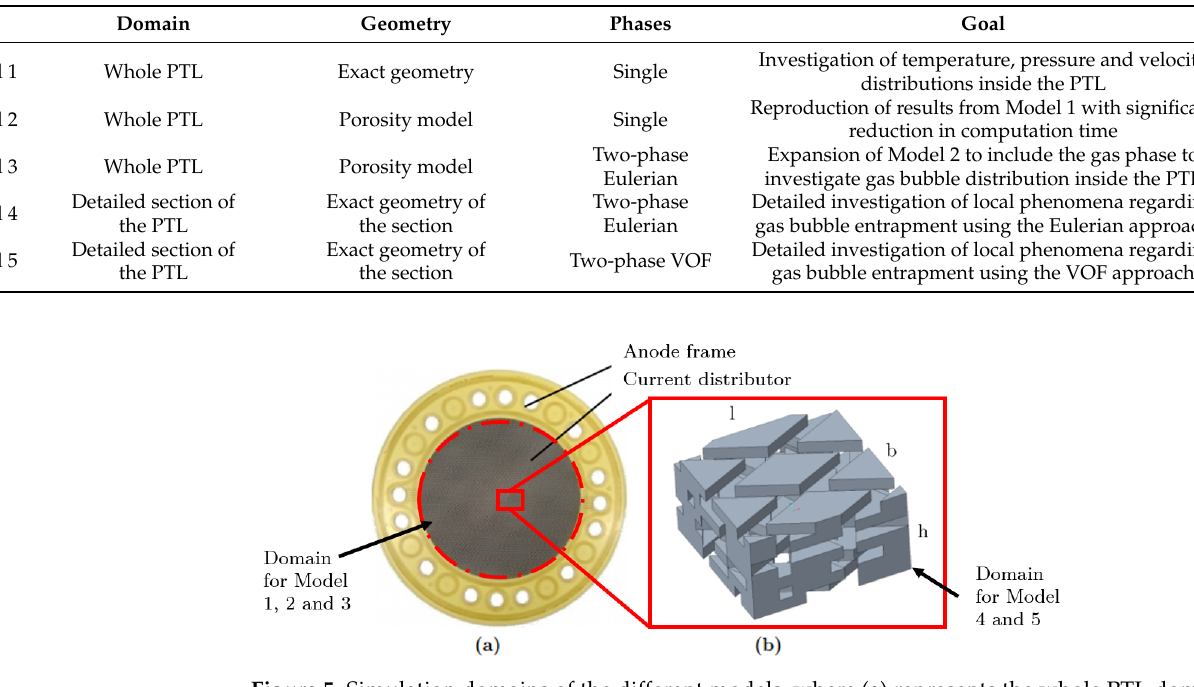
Figure 5. Simulation domains of the different models, where ( a ) represents the whole PTL domain used for models 1–3 and ( b ) represents a small section of the PTL used for models 4 and